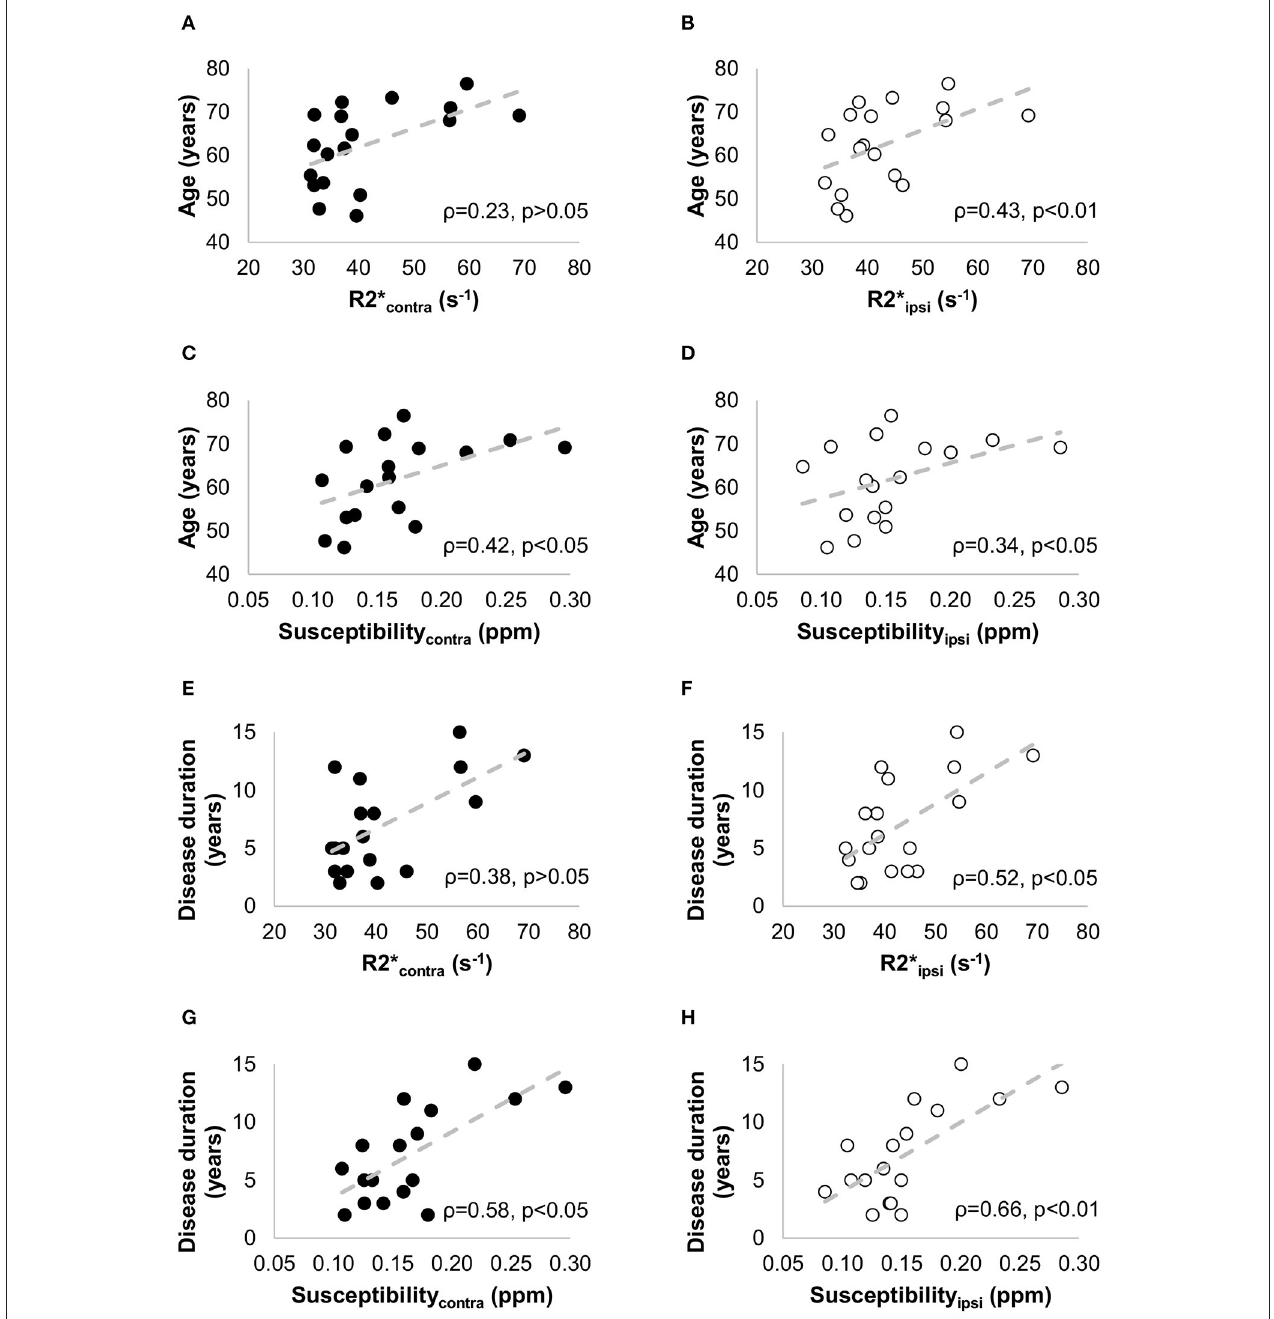
FIGURE 7 | Non parametric correlation analysis with linear regression between the clinical data [age (A–D) and disease duration (E–H)] and the iron-sensitive imaging measures [R2 * (A,B,E,F) and susceptibility (C,D,G,H)] in -patients with PD. The Spearman correlation coefficients ( ρ ) and the p -values are indicated in each figure. The filled circles correspond to the measurements in the contralateral side, and the empty circles to the measurements in the ipsilateral side.